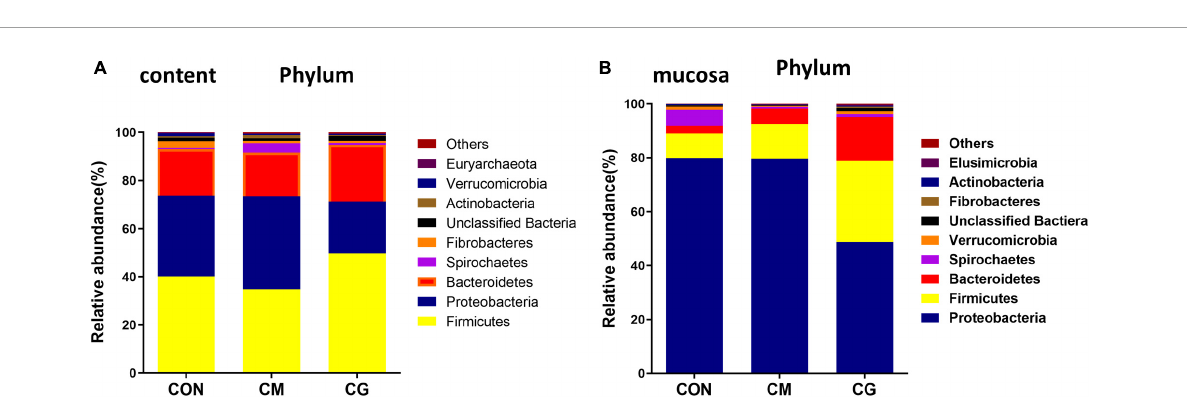
FIGURE3 Effects of low-grain fed (CON), maize meal high-grain fed (CM), and whole maize high-grain fed (CG) on the relative abundance of phylum level in colonic content and mucosa. (A) The distribution of phylum for each sample in colonic content. (B) Distribution of the phylum in colonic mucosa among the CON, CM, and CG